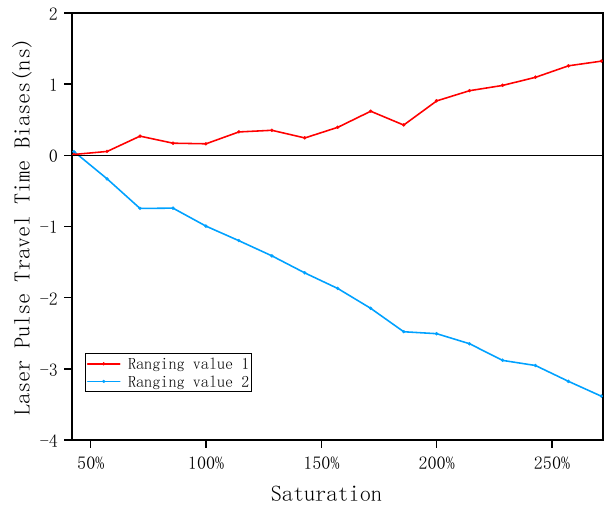
Figure 9. Ranging means deviation of high and low gain with different saturation.